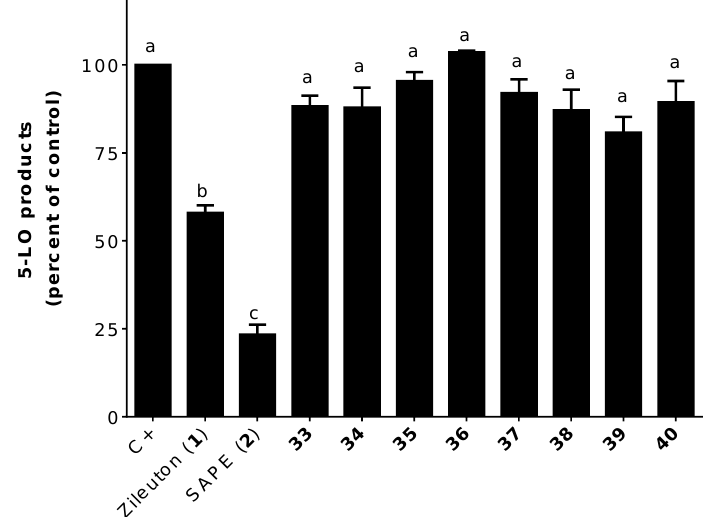
Figure 5. Inhibition of the biosynthesis of 5-LO products in stimulated HEK293 cells by zileuton ( 1 ; 1 μM), SAPE ( 2 ; 1 μM), and 33–40 (1 μM). Data are expressed as means ± SEM of at least three independent experiments. Values without one common superscript (a, b, or c) are significantly different determined by one-way ANOVA with Tukey’s multiple comparison test ( p < 0.05).